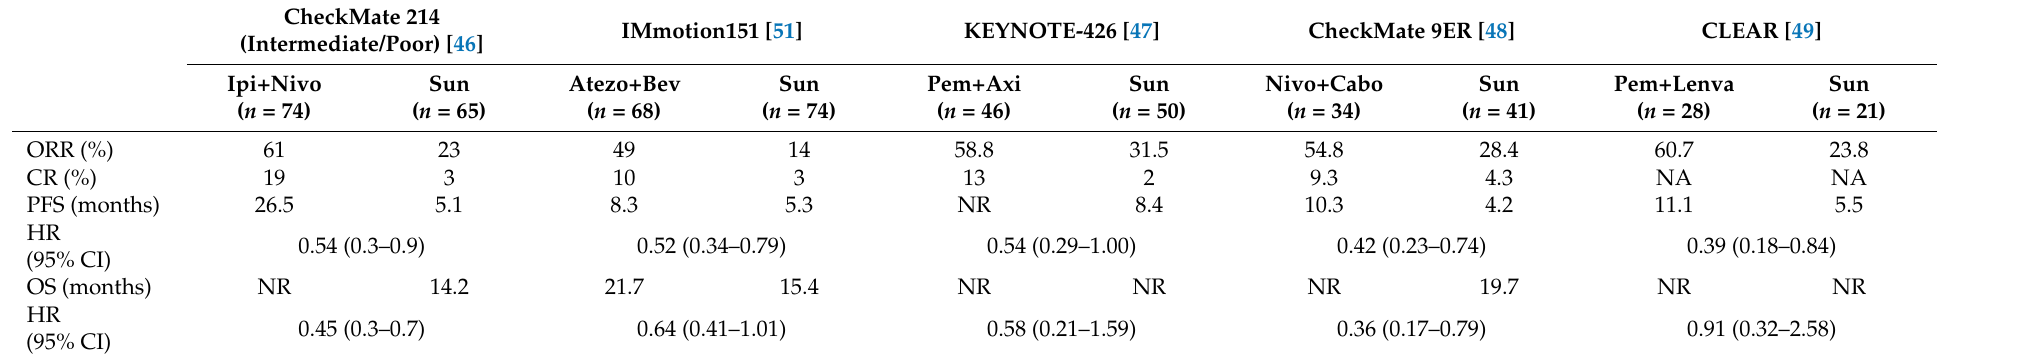
Table 3. Summary of efficacy of front-line ICI-based treatment in patients with sarcomatoid